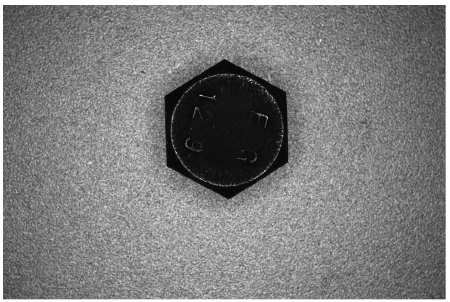
Figure 14. A screw image obtained by a